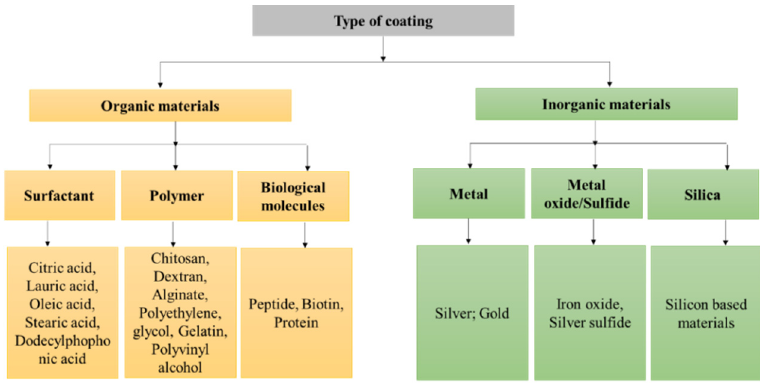
Figure 1. Types of materials applied as coating agents for MNPs.